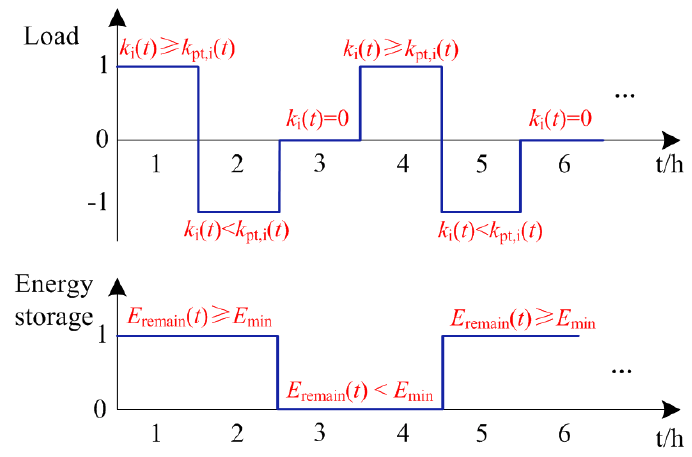
Figure 2. Off-grid operation sequential state simulation diagram.